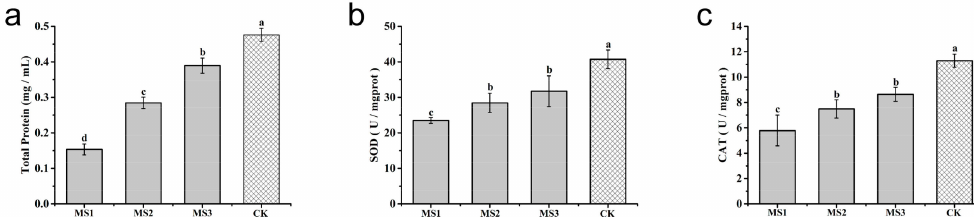
Figure 17. Effect of the azoxystrobin microspheres on soluble protein contents and anti-oxidase activities against Colletotrichum higginsianum Sacc. ( a ) Total protein; ( b ) SOD; ( c ) CAT. For soluble protein contents and anti-oxidase activities, different lowercase letters indicated statistically significant differences (one-way ANOVA, SNK test, p <